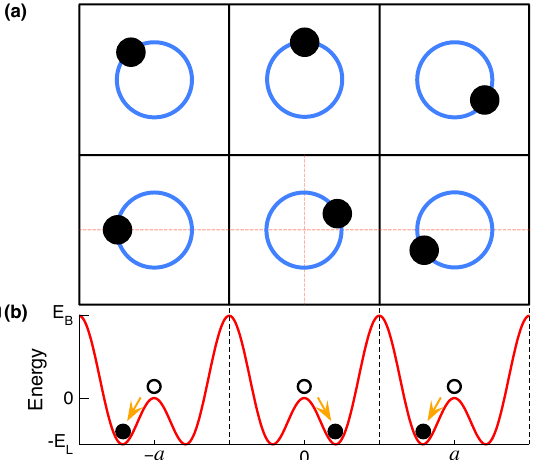
Figure 2. (color online) Schematic of 2D sombrero PE basins arranged in a square lattice. Energy cross section ( b ) along the horizontal dashed red line in panel ( a ) is identical to Figure 1b. See also corrugated sombrero potentials in Figure 3.